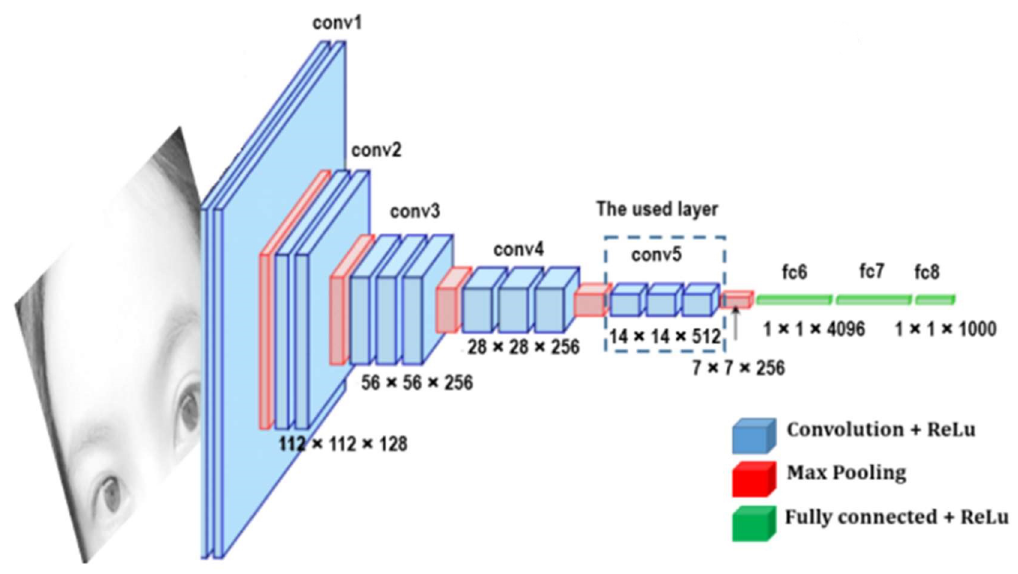
Figure 7. Architecture of VGG16 [17].